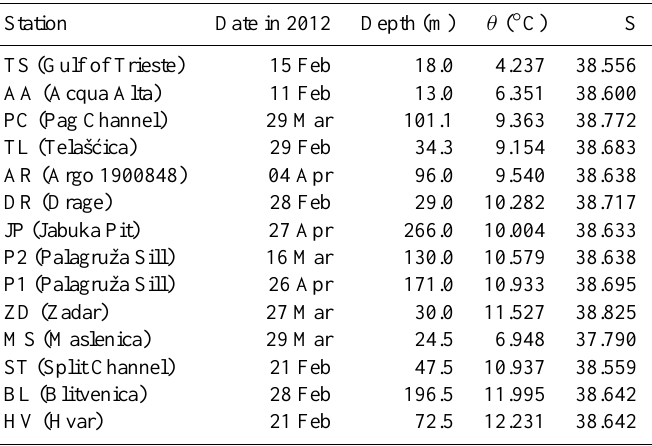
Table 1. Sampling dates, depths, potential temperatures ( θ ) and practical salinities corresponding to the potential density anomaly data presented in Fig.